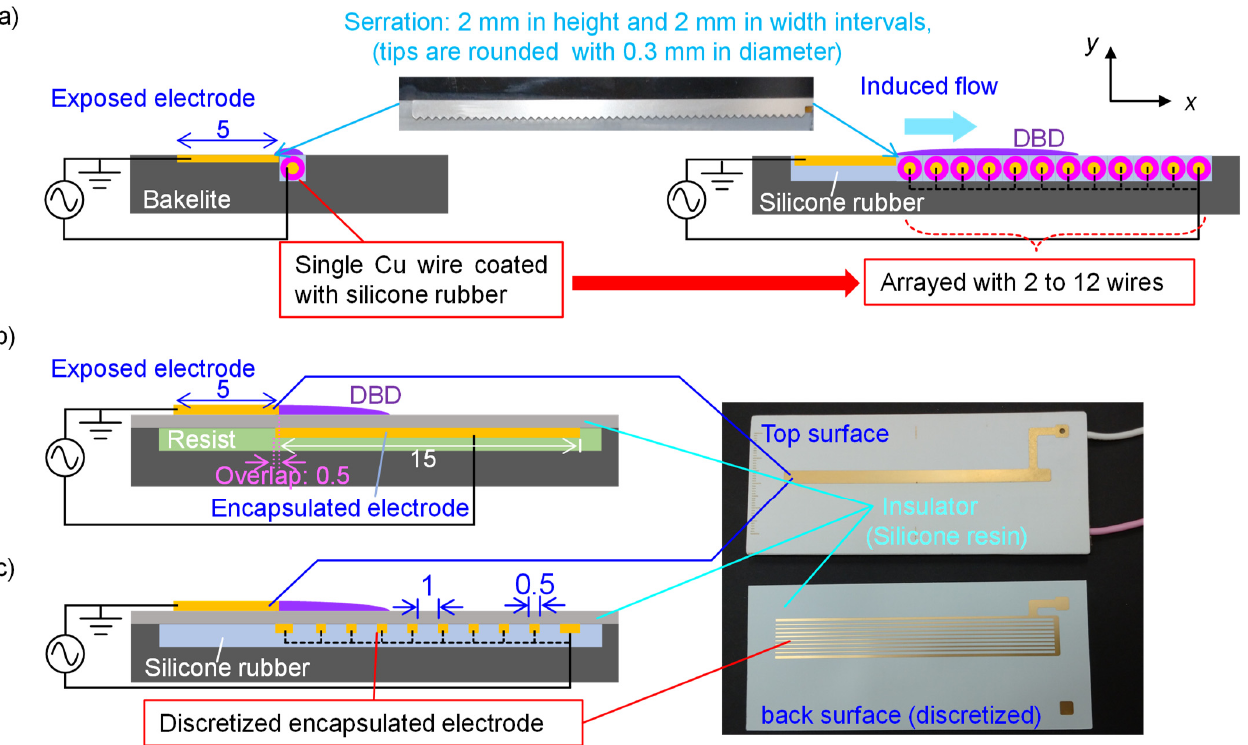
Figure 2. PA configurations used in this study: ( a ) string-type (single wire) and string-array-type (2–12 wires) PAs; ( b ) reference sheet-type PA; ( c ) discretized sheet-type PA.